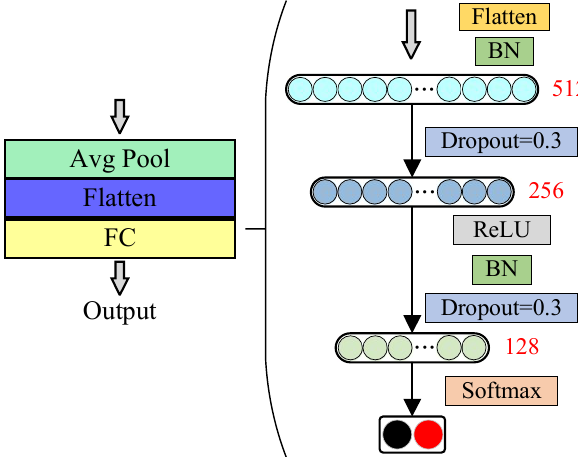
Figure 10. Fine-tuning of the ResNet50